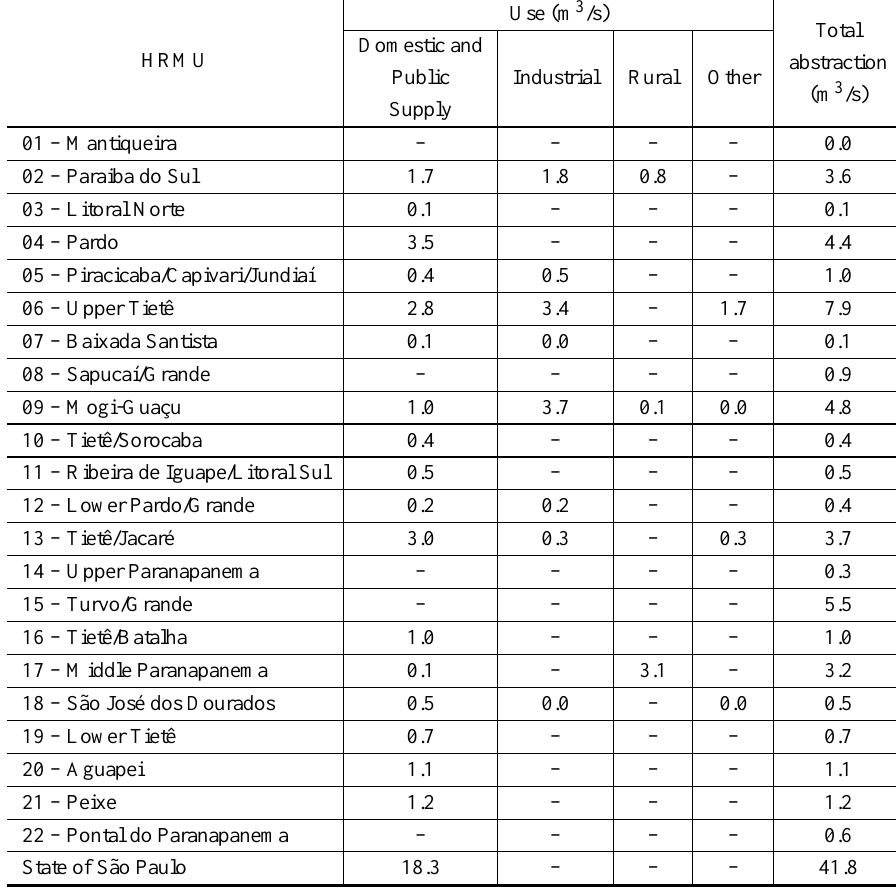
Groundwater use for the State of São Paulo (SEADE 2004,